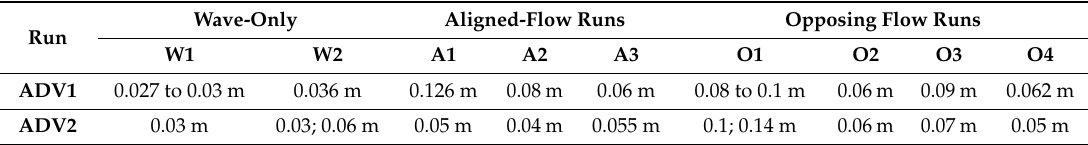
Table 4. Integral vertical length scales, L w (cid:48) (m), derived from non-dimensional wave-number spectra. Wave-Only Aligned-Flow Runs Opposing Flow Run